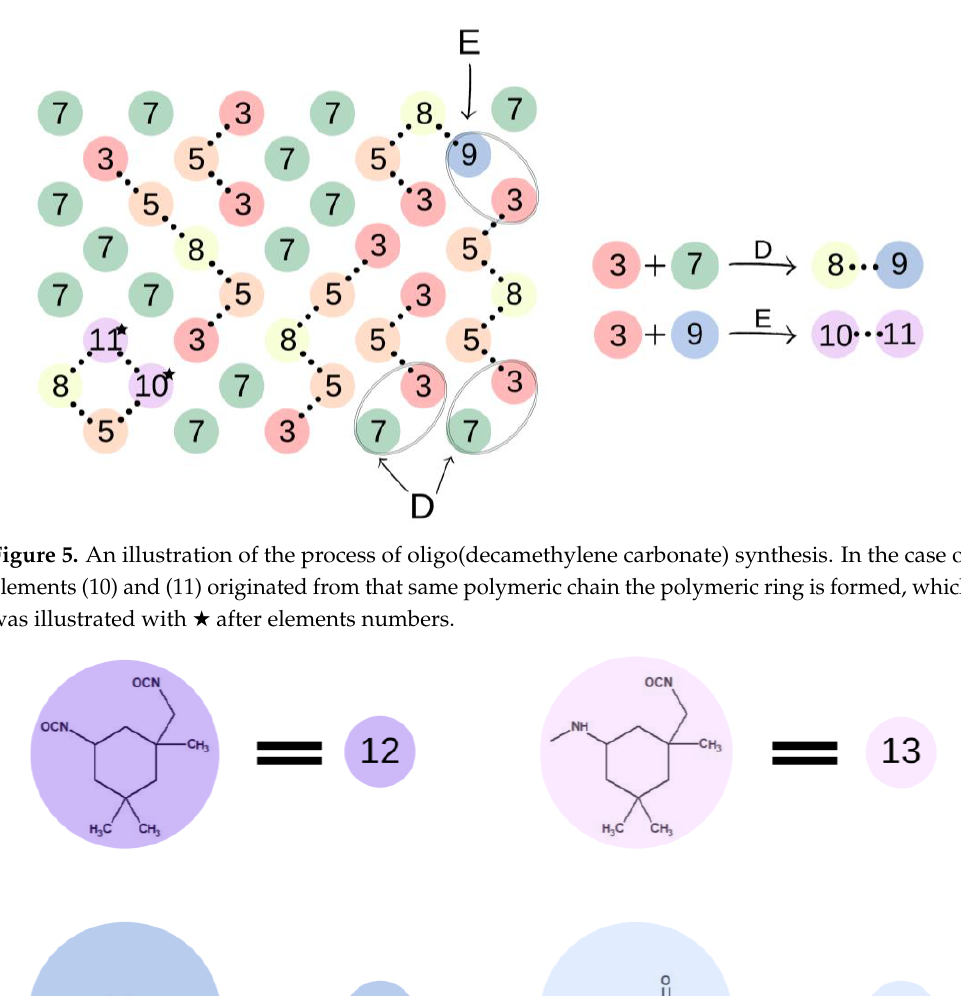
Figure 4. Schematic representation of the base units used in the second stage of the simulation.